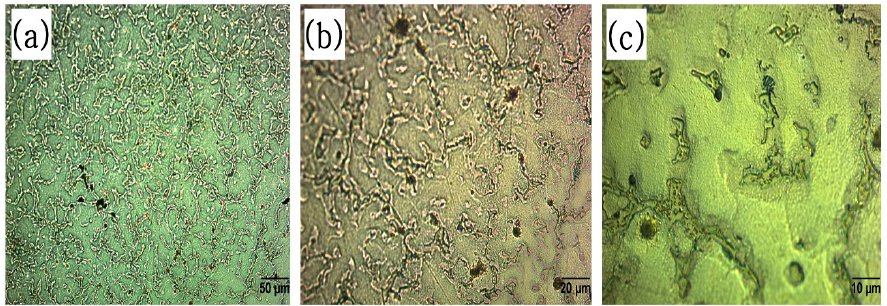
Figure 5. Representative microstructure of printed lines. Al 5 Mg 11 Zn 4 precipitate (j phase) embedded on a Mg matrix (a phase). ( a ) 20×; ( b ) 50×; ( c ) 100×.